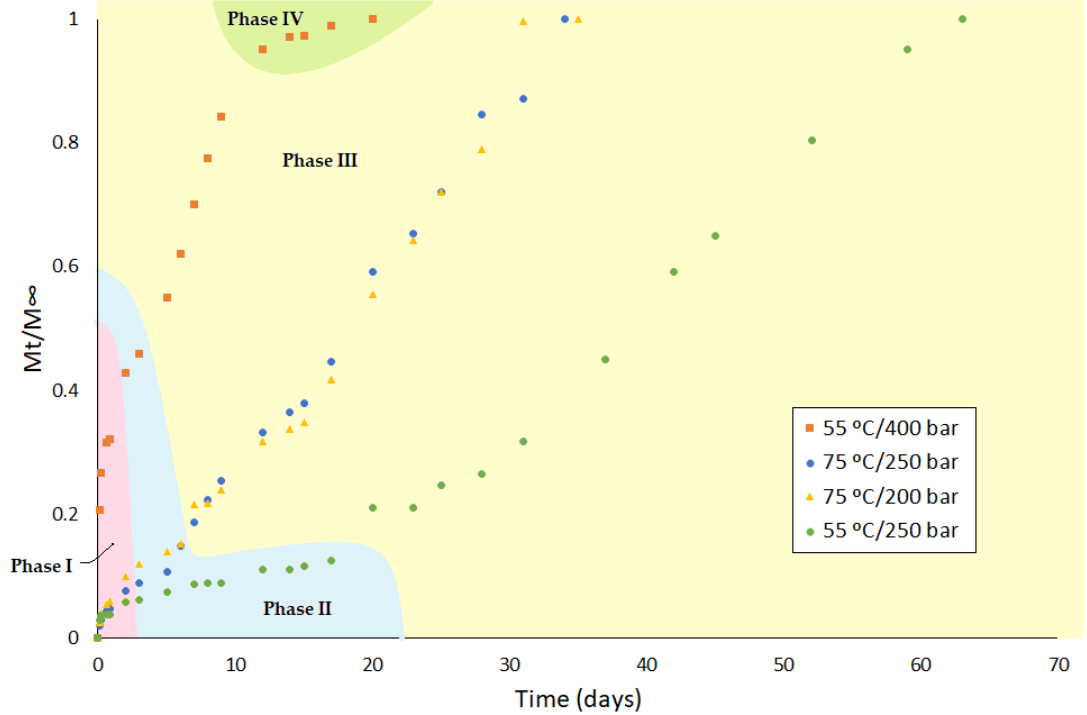
Figure 7. Release profiles including the different phases of the release process from the PLA filaments impregnated with ketoprofen under different conditions.